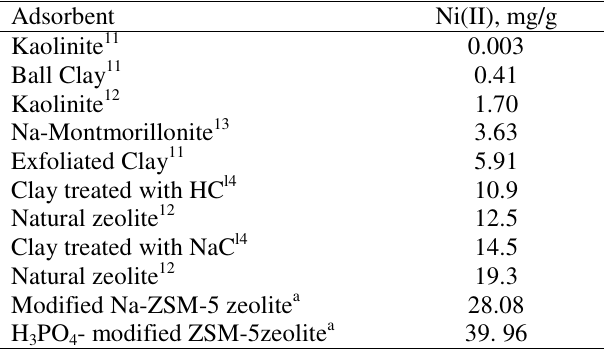
Table 2. Adsorption capacities Q o (mg/g) for some zeolite